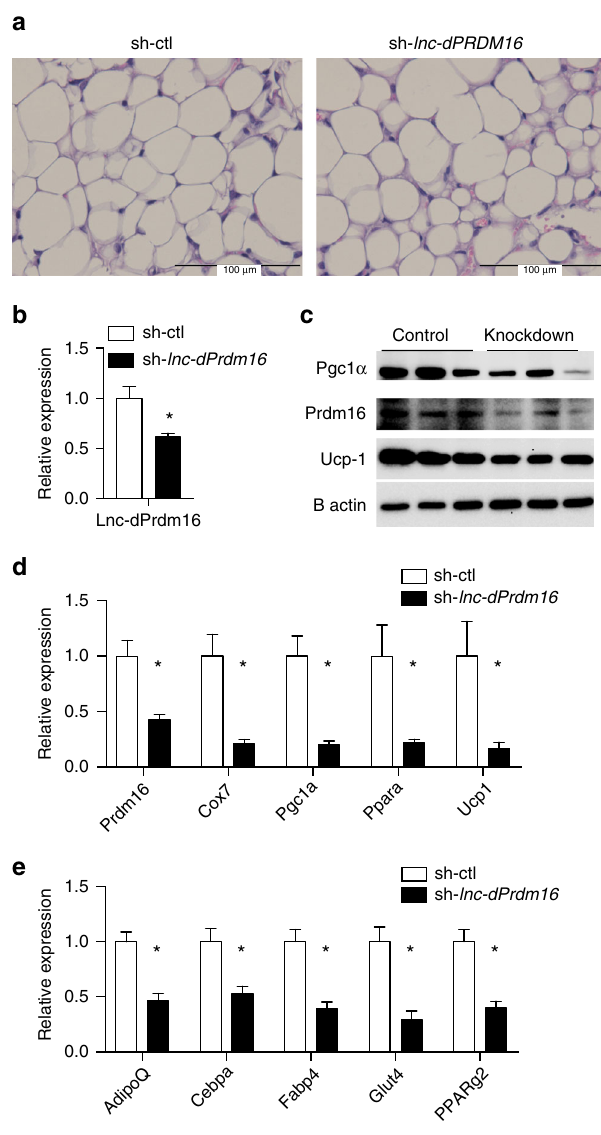
Fig. 9 The expression of lnc-dPrdm16 is required for iWAT browning. a Mice were infected by adenoviral sh-ctl and sh- lnc-dPrdm16 for 7 days, and then exposed to 4 °C for 24 h. H&E staining was conducted to examine the cellular morphology in iWAT tissue. b Real-time PCR to examine the expression change of lnc-dPrdm16 . sh-ctl, n = 8, sh- lnc-dPrdm16 , n = 5. c Western blot to examine the protein level change of BAT-selective markers. d , e Real-time PCR to examine the BAT-selective marker expression ( d ) and pan-adipogenic markers ( e ). sh-ctl, n = 8, sh- lnc-dPrdm16 , n = 5. Error bars represent mean±SEM, * p <0.05, Student ’ s T